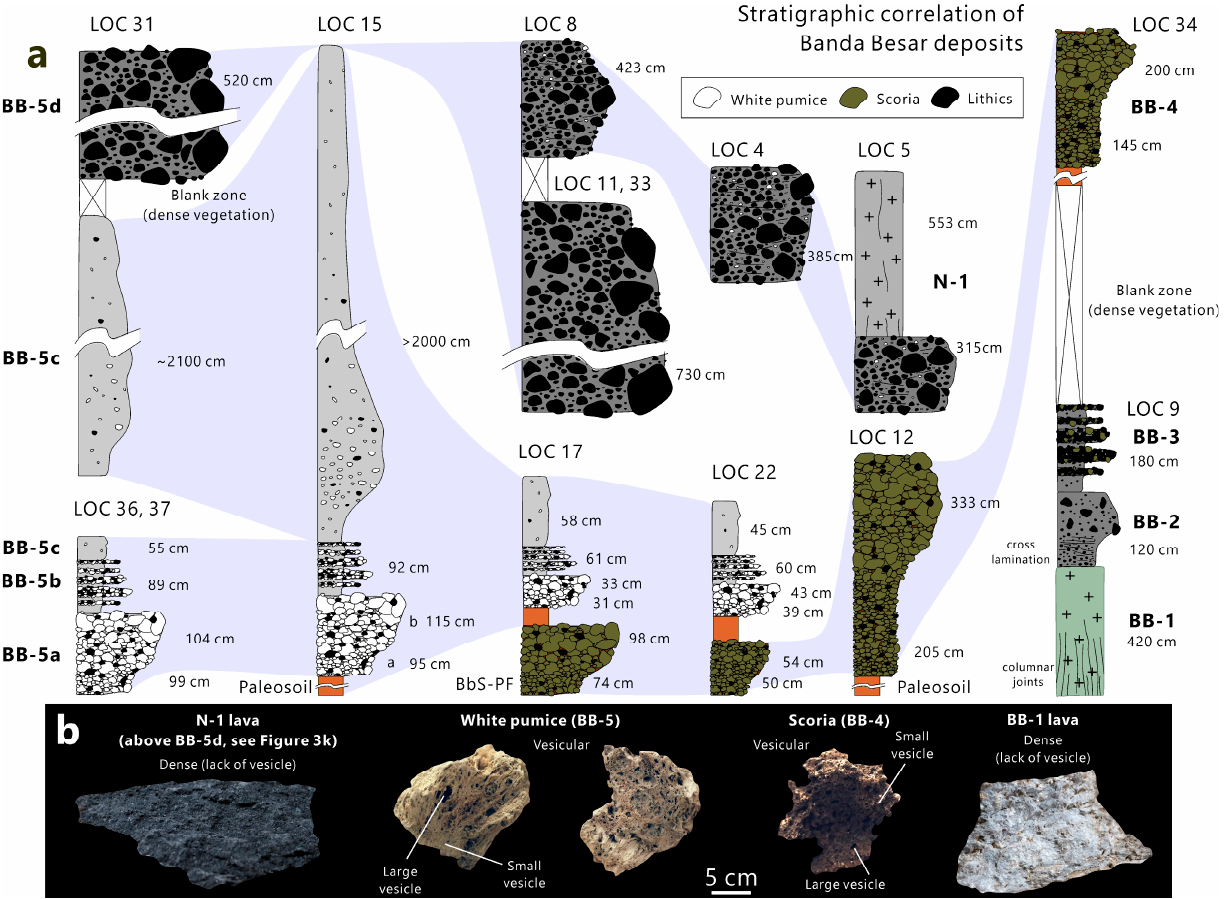
Figure 4. ( a ) Stratigraphic correlation of Banda Besar eruptive units (BB-1 to BB-5). White, dark green, and black-colored grains represent white pumice, scoria, and lithics, respectively. ( b ) Representative images of Banda Besar white pumice, scoria, and lava. Naira lava (N-1) is also shown here, as it shows contact with BB-5d.